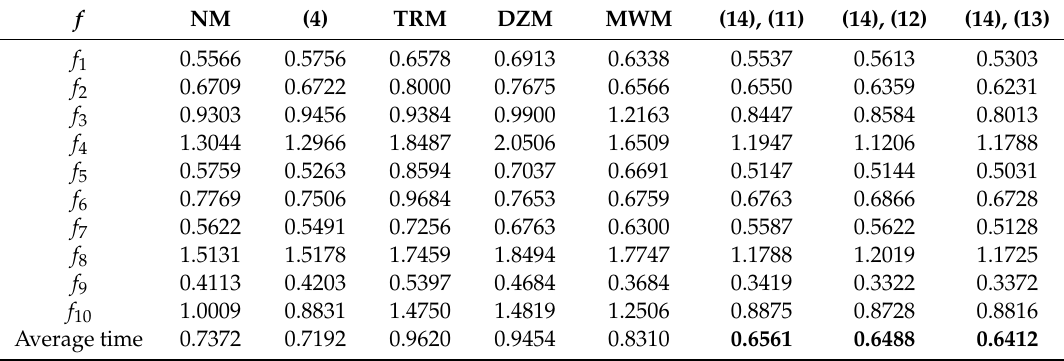
Table 12. Mean CPU time of iterative method for solving di ff erent